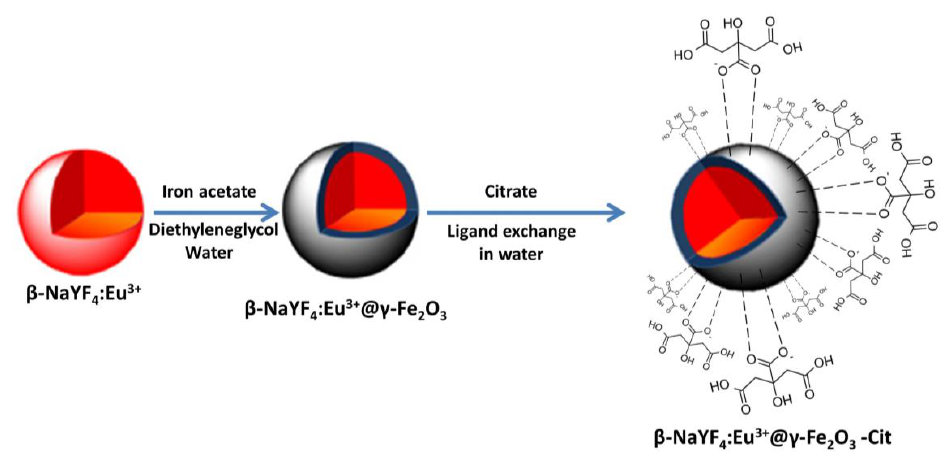
Figure 1. Schematic representation of the chemical strategy used to produce water-dispersible β-NaY 0.8 Eu 0.2 F 4 @γ-Fe 2 O 3 nanoparticles (NPs). To be as synthetic as possible, only the coordination of citrate ligands through their carboxylate groups to the particle surface was